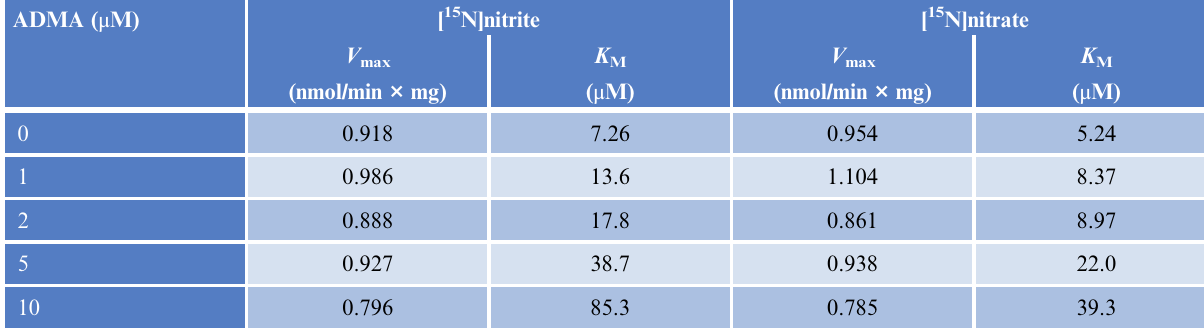
Table 3. Michaelis – Menten constants for recombinant bovine eNOS ADMA ( μ